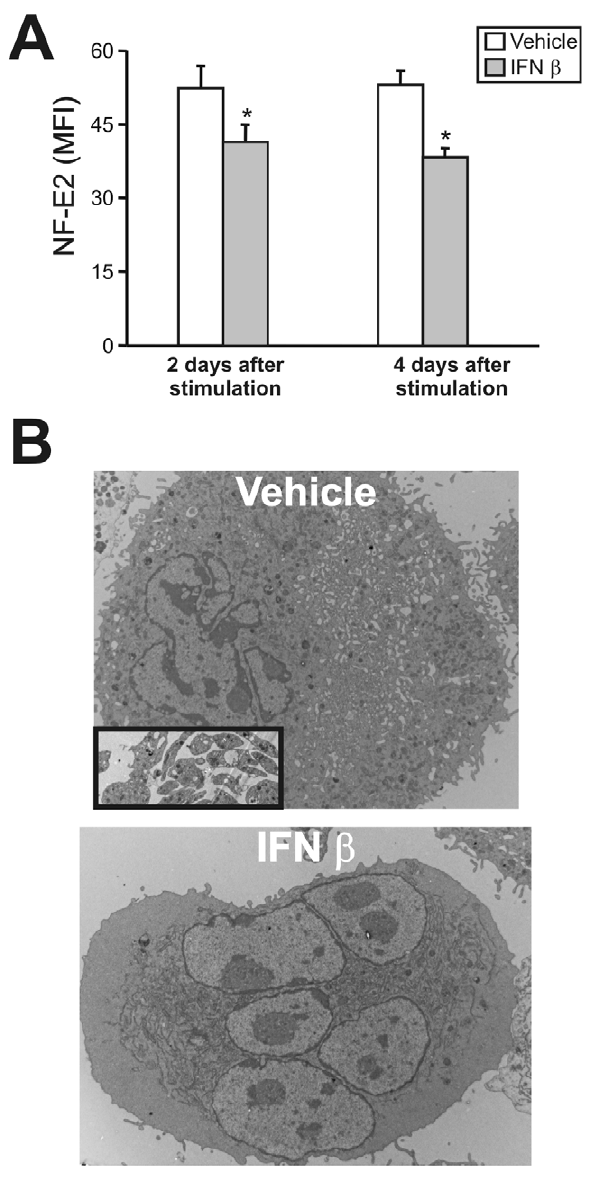
Figure 8. NF-E2 expression and ultrastructural studies of megakaryocytes treated with IFN b . (A) After 12 days of CD34 + cell TPO stimulation, megakaryocytes were purified by immunomag- netic positive selection (98 6 1% of purity) and NF-E2 expression was determined two or four days after IFN b (10 U/ml) treatment using the anti-NF-E2 polyclonal Ab (or rabbit serum) followed by FITC-conjugated swine anti-rabbit Igs. The values represent the mean 6 SEM of three independent experiments, * indicates p , 0.05 vs. vehicle. (B) Ultrastruc- ture of megakaryocytes cultured in the presence of vehicle or IFN b from day seven to day fourteen. Inset in the upper panel shows culture- derived platelets observed only in vehicle-treated samples.